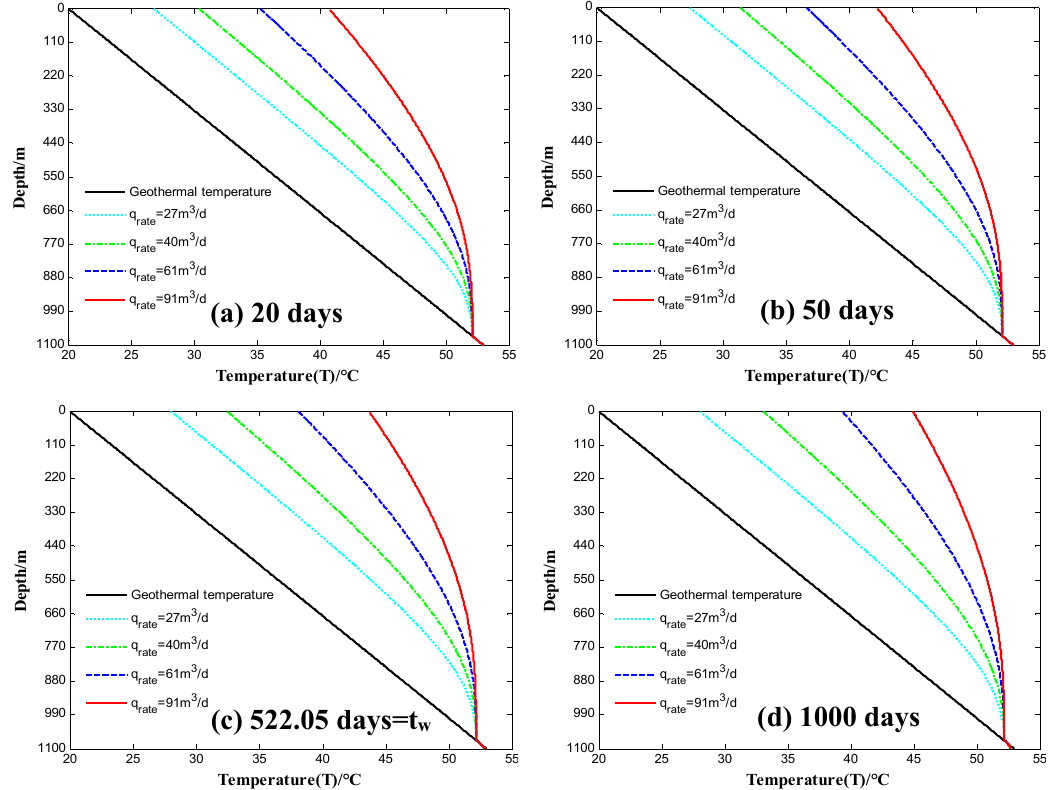
Figure 16. Fluid temperature in vertical tubing at the tubing-tubing wall interface ( r = 0.04 m, 0 m ≤ z ≤ 1100 m) with a different flow rate of wellhead ( q rate ). (a), (b), (c), (d) are the temperature profiles of 20, 50, 522.05, 1000 days of production time, respectively.